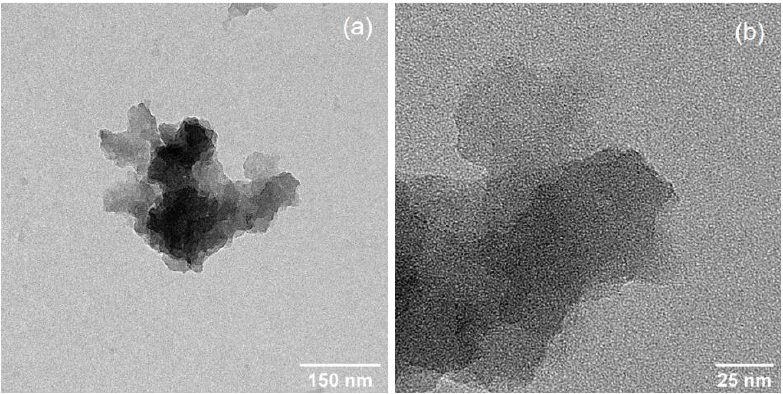
Figure 3. SEM images of GCF at ( a ) 100× and ( b ) 1000× magnification.